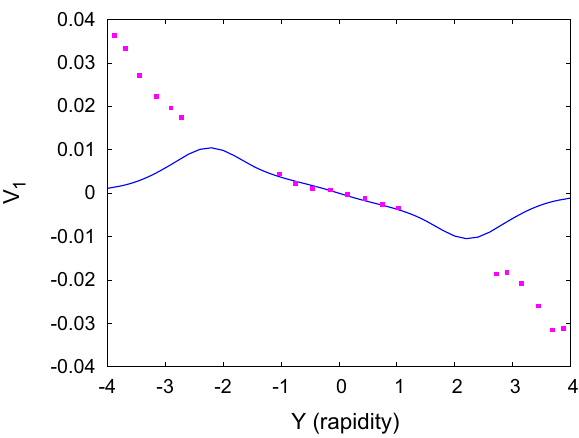
Fig. 7 Directedflowofpionsfordifferentvaluesof η/ s with η m = 2 . 0 compared with STAR data [1]